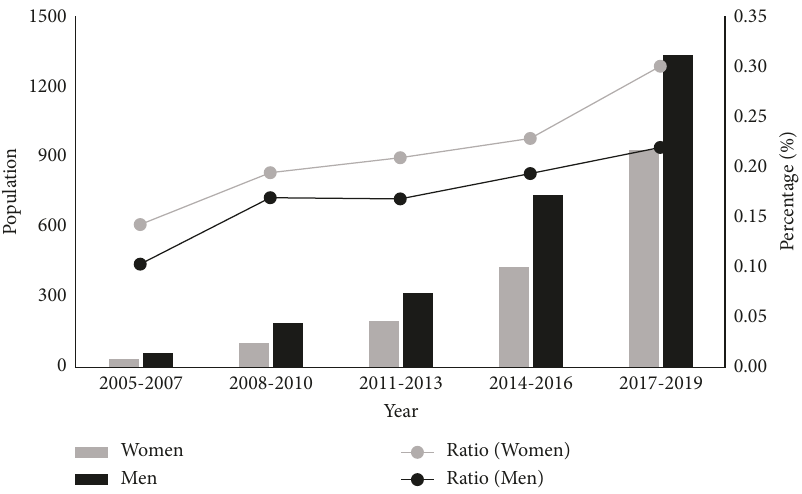
Figure 3: Temporal trends of the CHADS